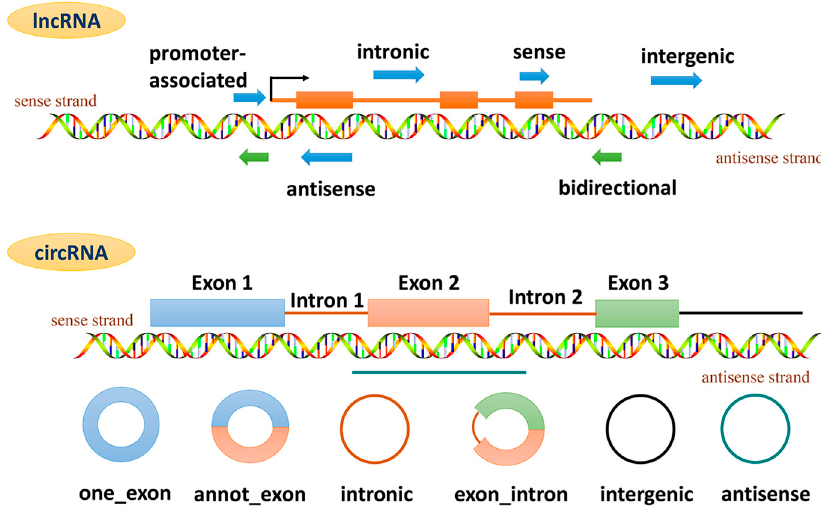
Figure 1. Long non-coding RNA (lncRNA) and circular RNA (circRNA) classification based on genomic location and context.